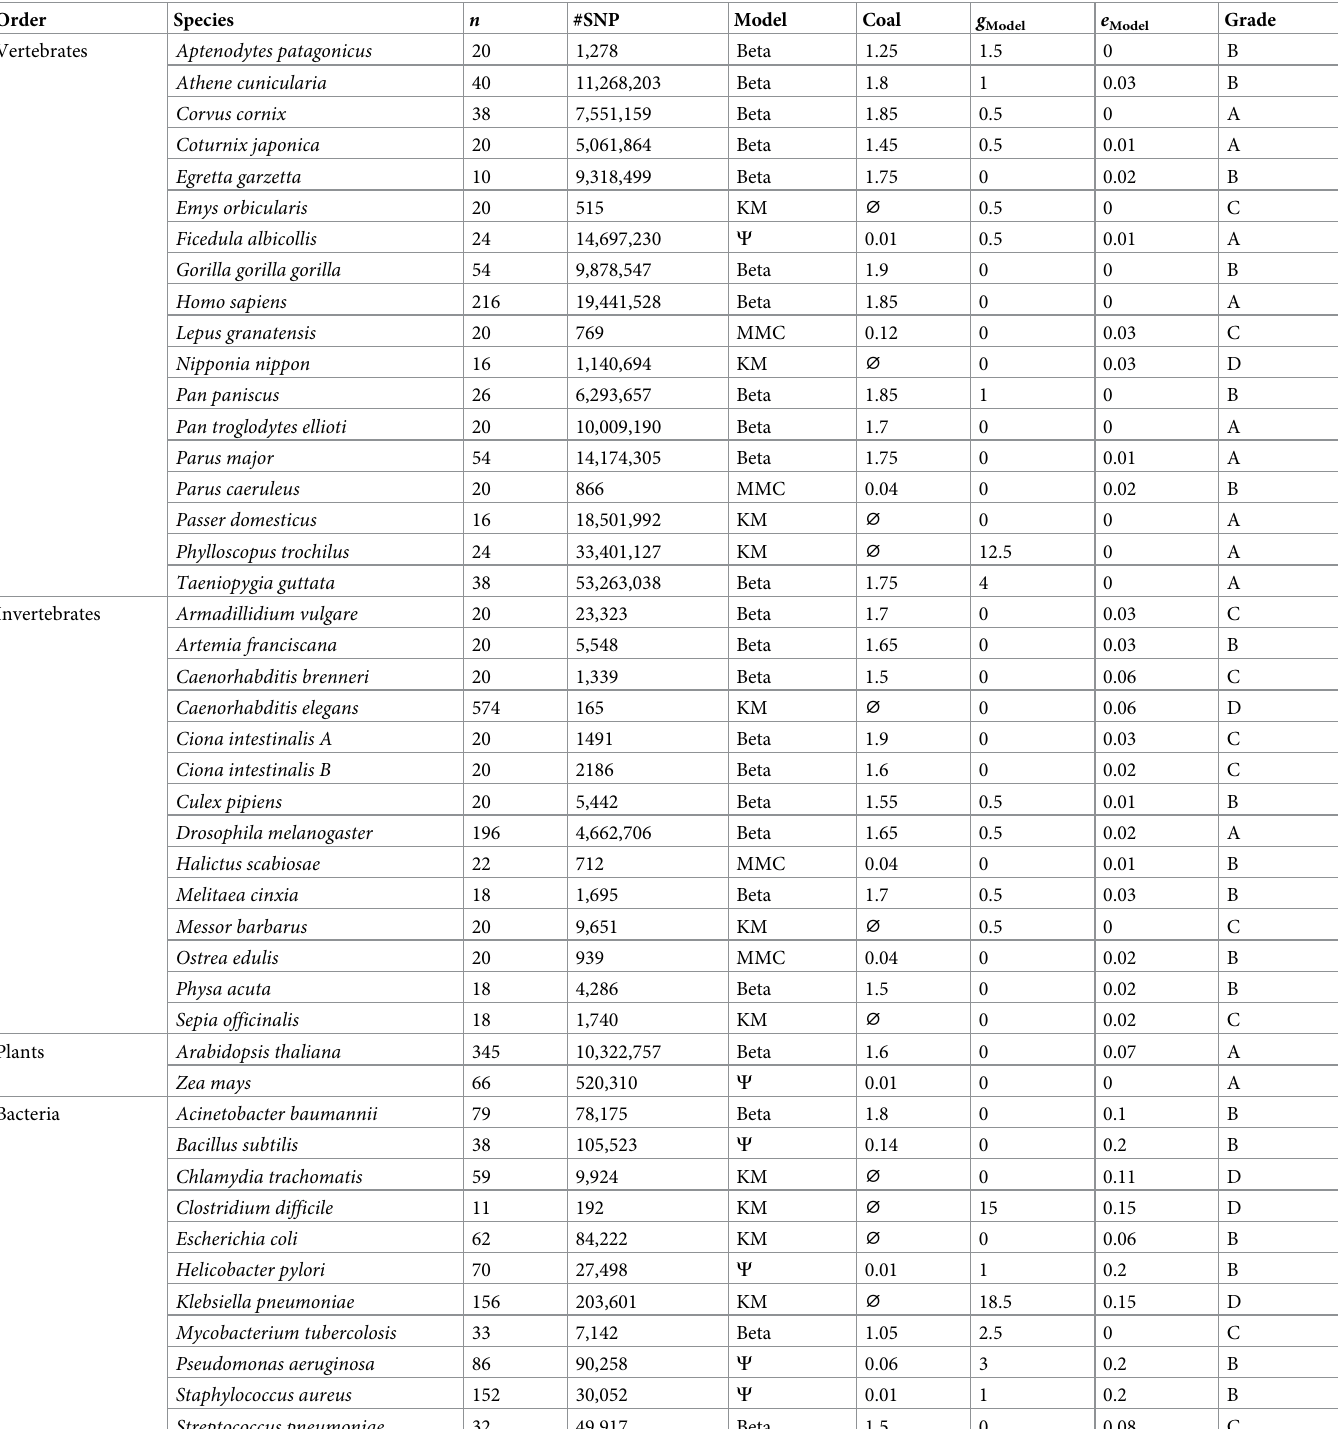
Table 2. Data sets description: Taxa, Species, number of haplotypes ( n ) and number of polymorphic sites (#SNP). Best fitting model (Kingman (KM), Beta, Psi-coales- cent or no preference between Multiple Merger Coalescents (MMC)), its parameters (parameters describing coalescence (Coal), growth rate ( g ) and misorientation ( e )) and goodness-of-fit grade from Crame´r’s V